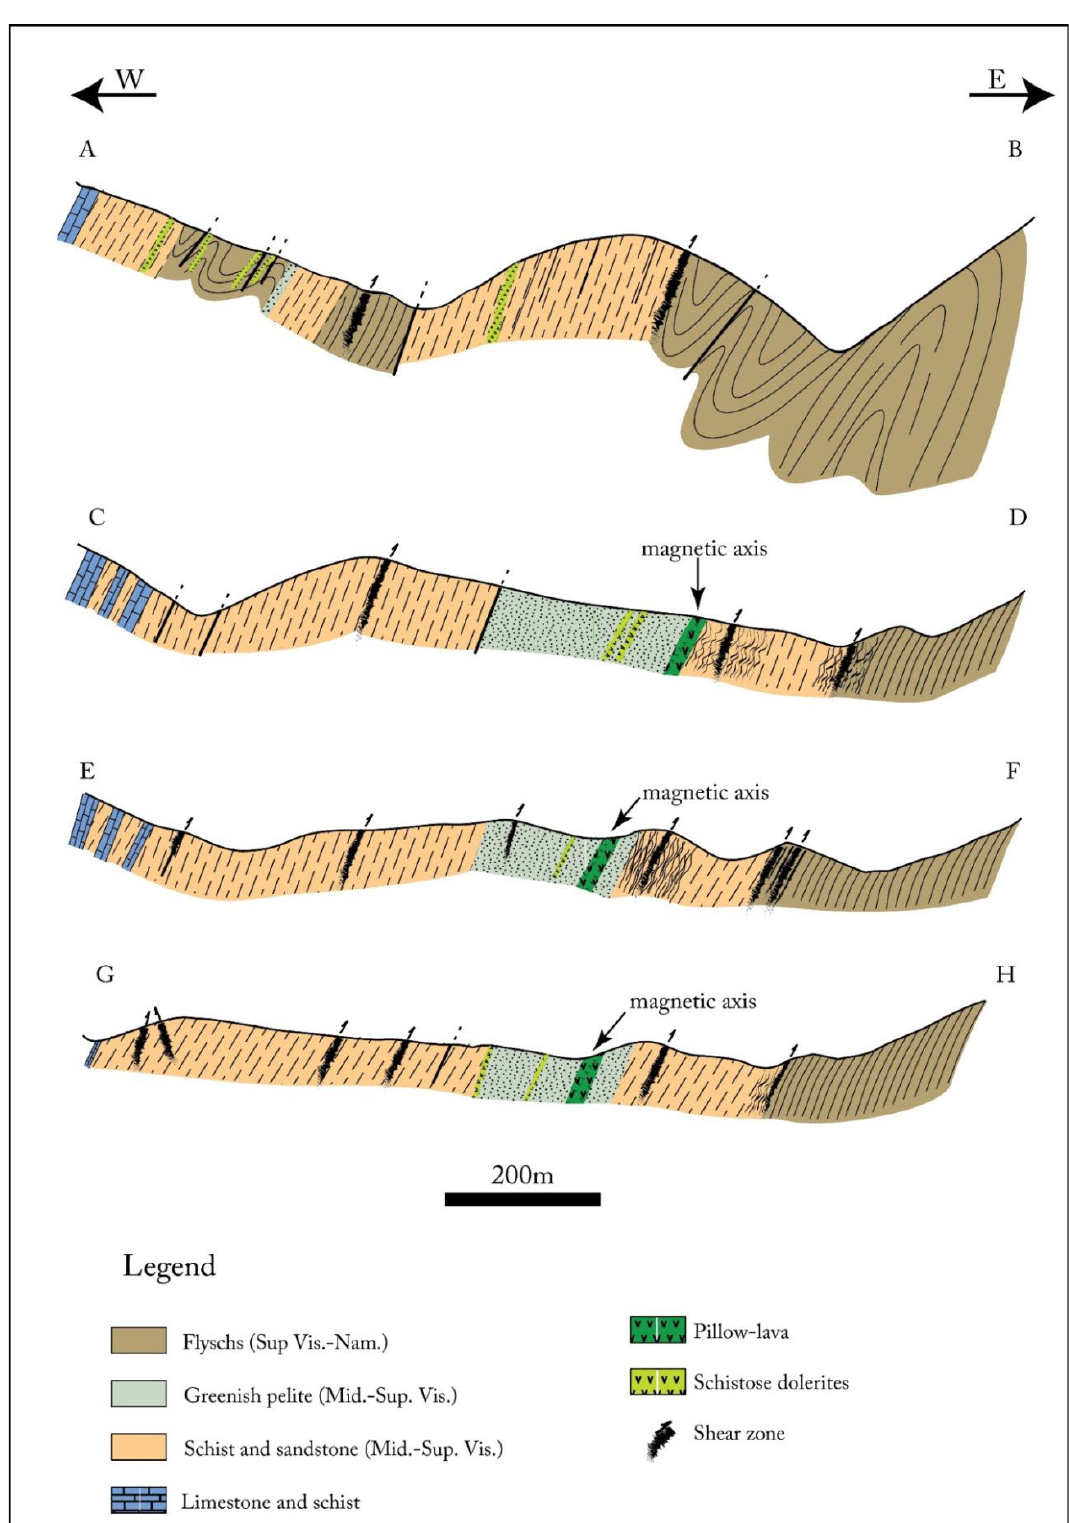
Figure 9. E-W geological sections (AB, CD, EF and GH) of the NNE Achemmach. See cross-section position in Figure 3.